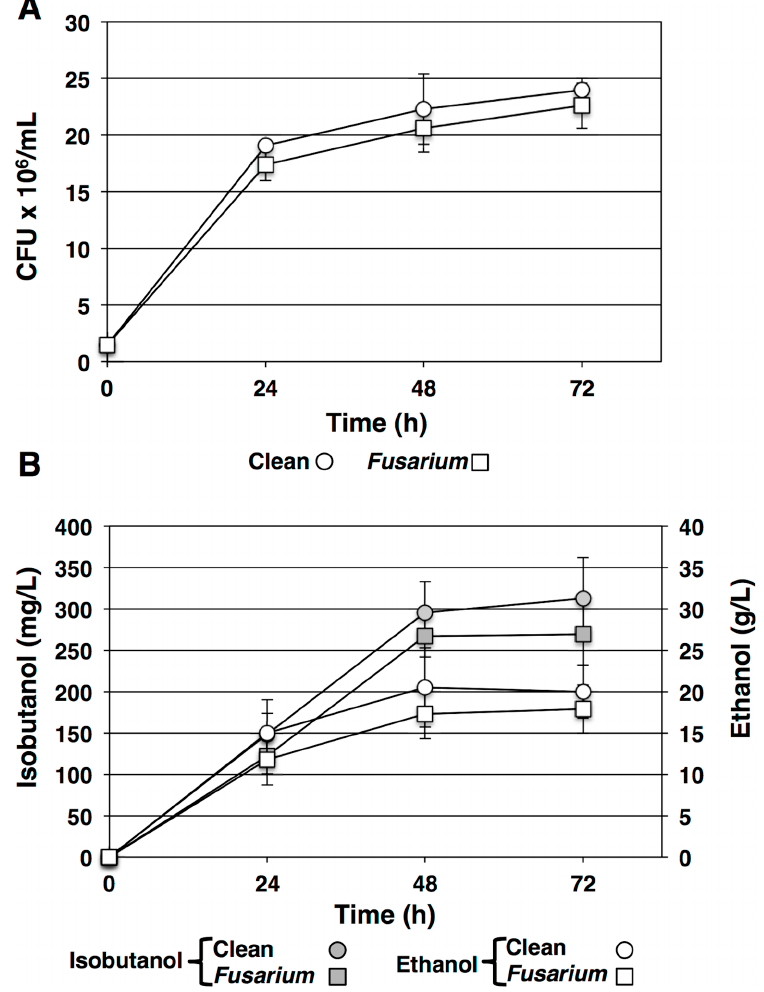
Figure 3. SSF of uninfected (Clean, circles) and F. graminearum infected ( Fusarium, squares) barley . ( A ). Viable yeast cell counts at each time point from fermentation of clean barley starch feedstock (circles) or barley starch prepared from barley experimentally infected with F. graminearum (squares) by CFU. Data shown are mean values from triplicate platings. Error bars indicate stand- ard deviation. ( B ) Isobutanol concentration in mg/L (filled symbols) and ethanol concentration in g/L (open symbols) was measured in fermentation reactions fed with clean barley starch (circles) or F. graminearum- infected barley starch (squares). Values displayed are the means of triplicate measures. Error bars indicate standard